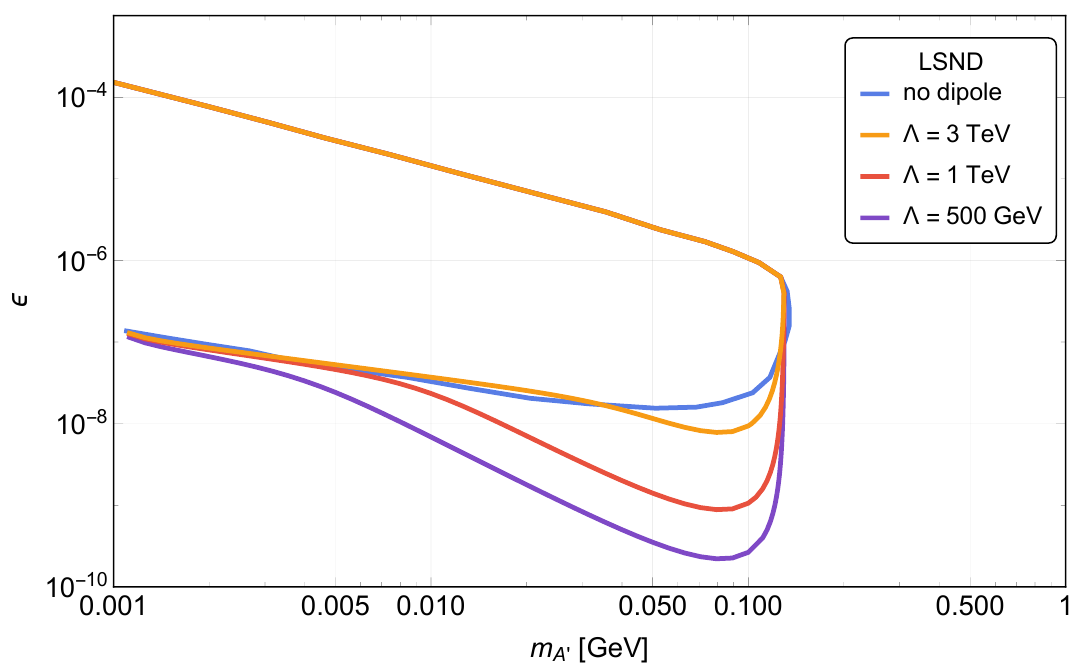
Figure 5 . Exclusion region obtained for LSND assuming the detection of at least 10 dark photon events. The blue curve denotes the limit obtained in the absence of the dipole operator, while the other curves show the limits for different values of Λ by fixing d